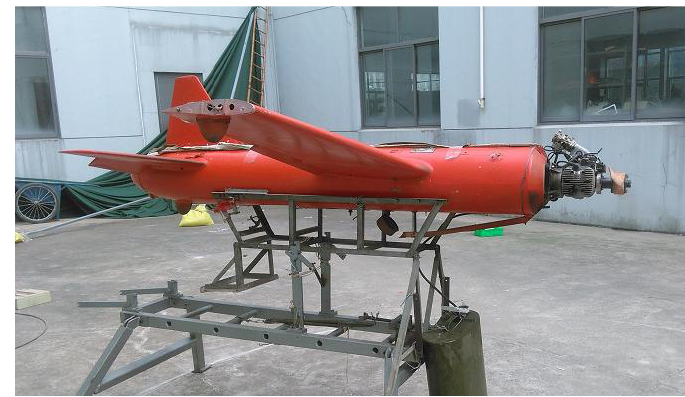
Figure 1. The unmanned aerial vehicle (UAV).